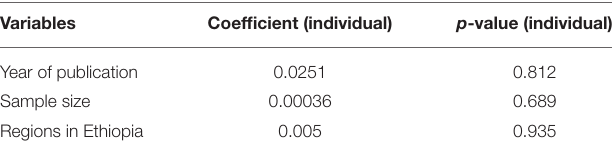
TABLE 2 | Heterogeneity of post-abortion contraceptive utilization in the current meta-analysis (based on univariate meta-regression considering the year of publication, sample size, and regions in Ethiopia as a